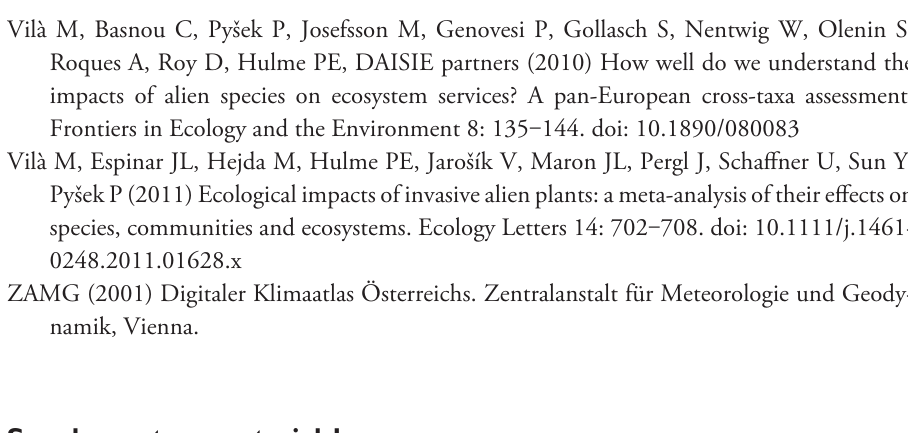
Figure S1. Distribution of the three study species ( F. × bohemica , I. glandulifera ,